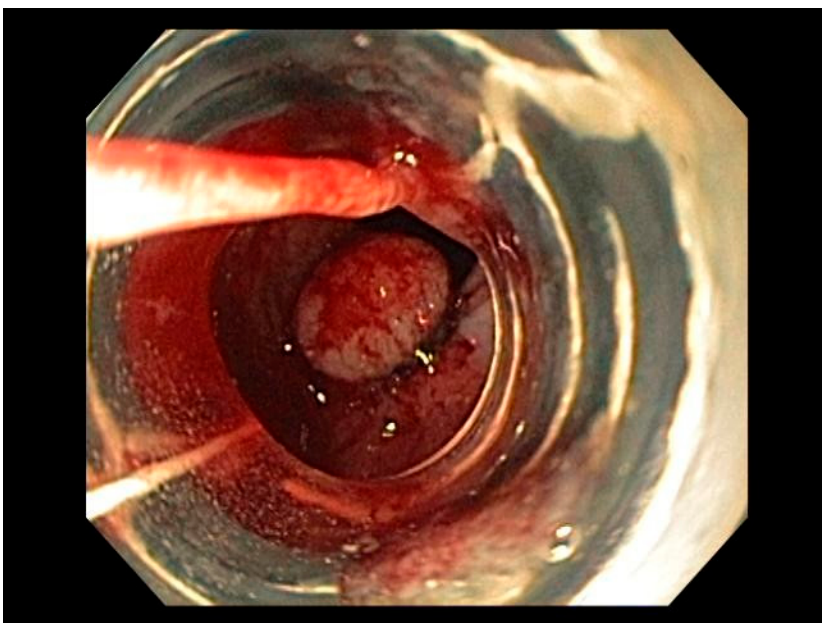
Figure 5. Band-assisted mucosectomy.